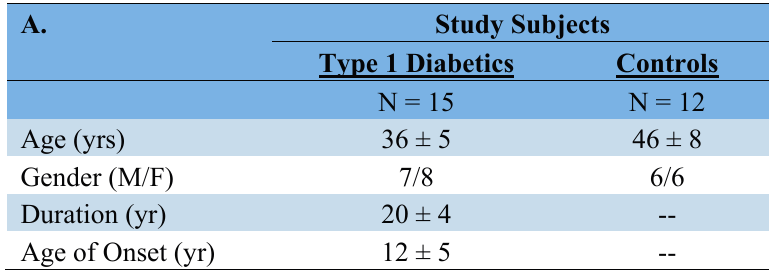
Table 1. Characteristics of study subjects with type 1 diabetes compared to control